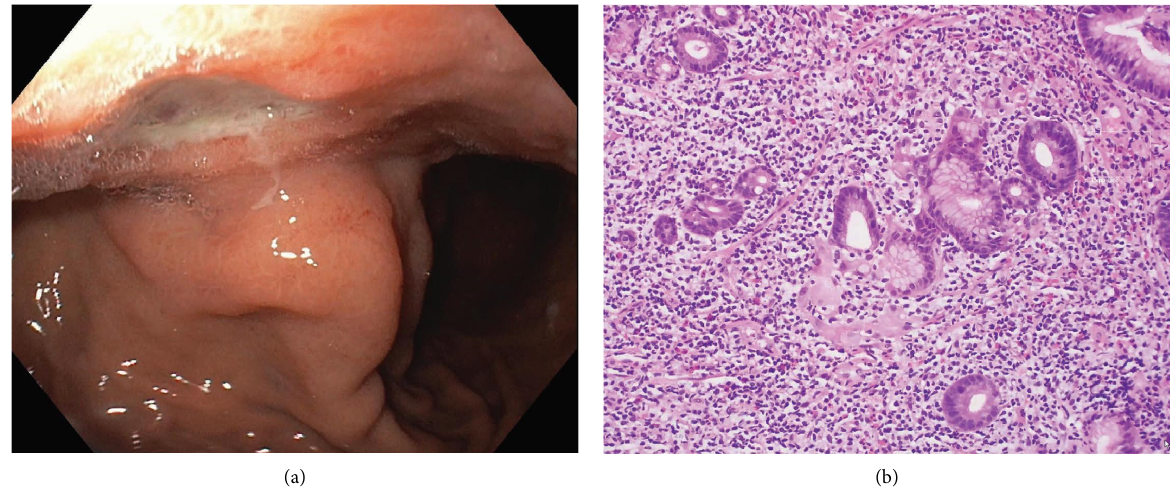
Figure 1: Endoscopic image of gastric ulcer in frst case (a). Microscopic image H&E stained 400 × of lymphoepithelial lesion with surrounding lymphocyte mucosal invasion (b).